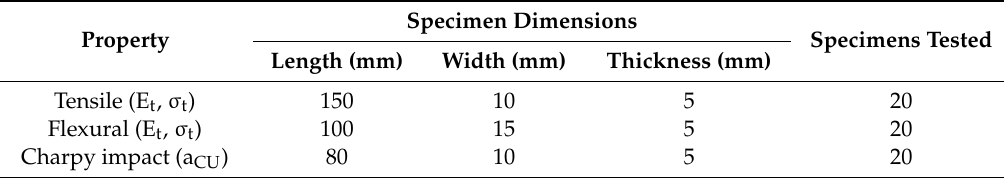
Table 3. Specimen dimensions and number of specimens